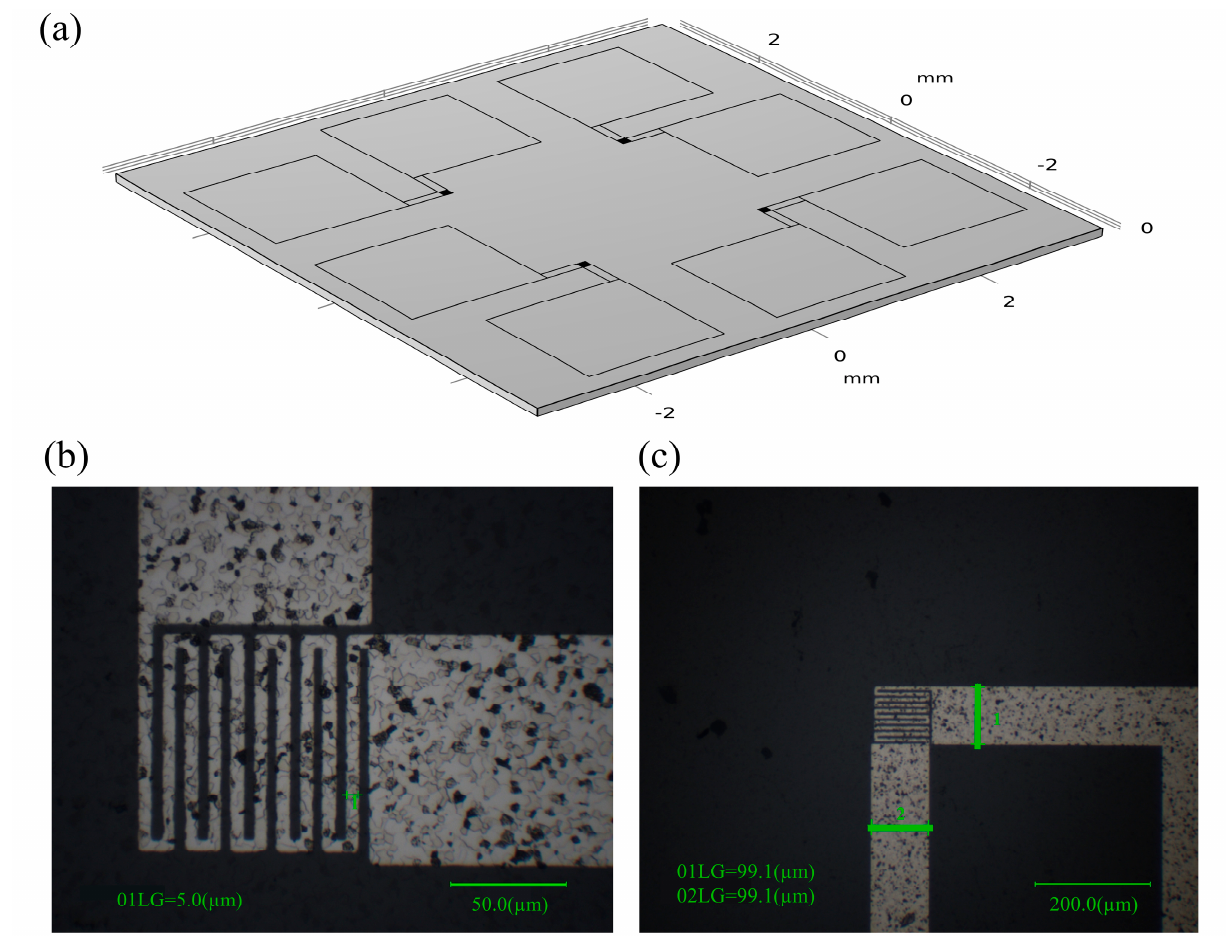
Figure 1. Structure diagram of three-dimensional micrometer array heat flux sensor. ( a ) The structure diagram of the new three-dimensional micrometer array heat flow sensor. ( b , c ) Pt film sensing unit under an optical microscope.